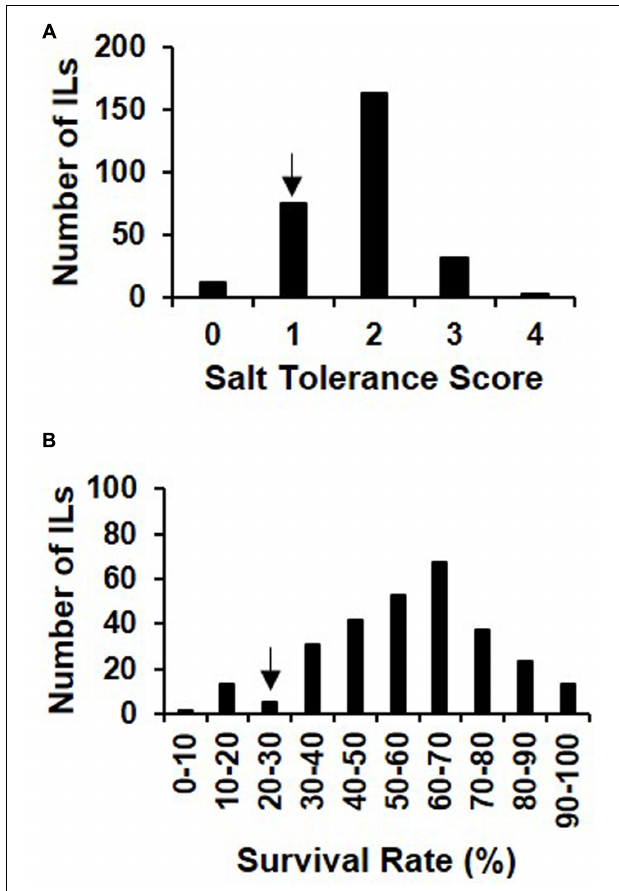
FIGURE 1 | Frequency distribution of salt tolerance score (A) of seedlings and survival rate (B) in introgression lines under 125 mM NaCl treatment for 9 days and recovery for 7 days. The phenotype of the recurrent parent, 93-11, is indicated by arrows.